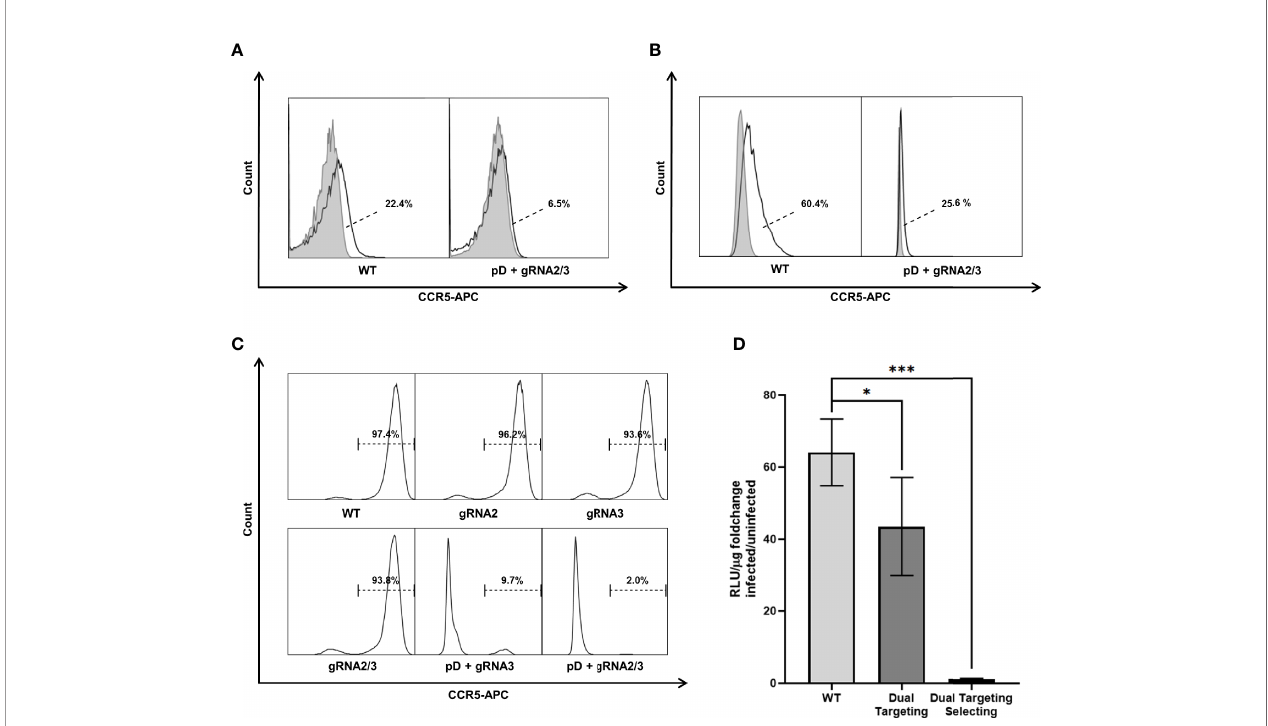
FIGURE 5 | CCR5 surface expression was analyzed by fl ow cytometry in three different cell types. Untreated (WT) as well as dual targeted-selected (pD+gRNA2/3) populations were stained with an APC labeled Anti-CCR5 Antibody (black lined graph). Unstained negative samples (light gray fi lled graph) are shown to distinguish the CCR5 positive fraction. (A) Jurkat. (B) ASC. Fractions are presented next to the Graph. The dashed line points towards the CCR5 positive subset (white area) as calculated by overton subtraction technique. (C) TZM-bl includes additional differently targeted populations. Because of the easily distinguishable positive population, only the stained samples are shown. (D) HIV-1 infectivity of TZM-bl was measured by Luciferase Assay. Cell lysate was obtained 48h after infection with HIV-1 BaL . Uninfected cells were used to measure the background signal. All experiments were carried out in quadruplicates. The results are presented as the fold change in luciferase activity by infection. Error bars show±SD and signi fi cant changes are represented as p-values (*p<0.05,